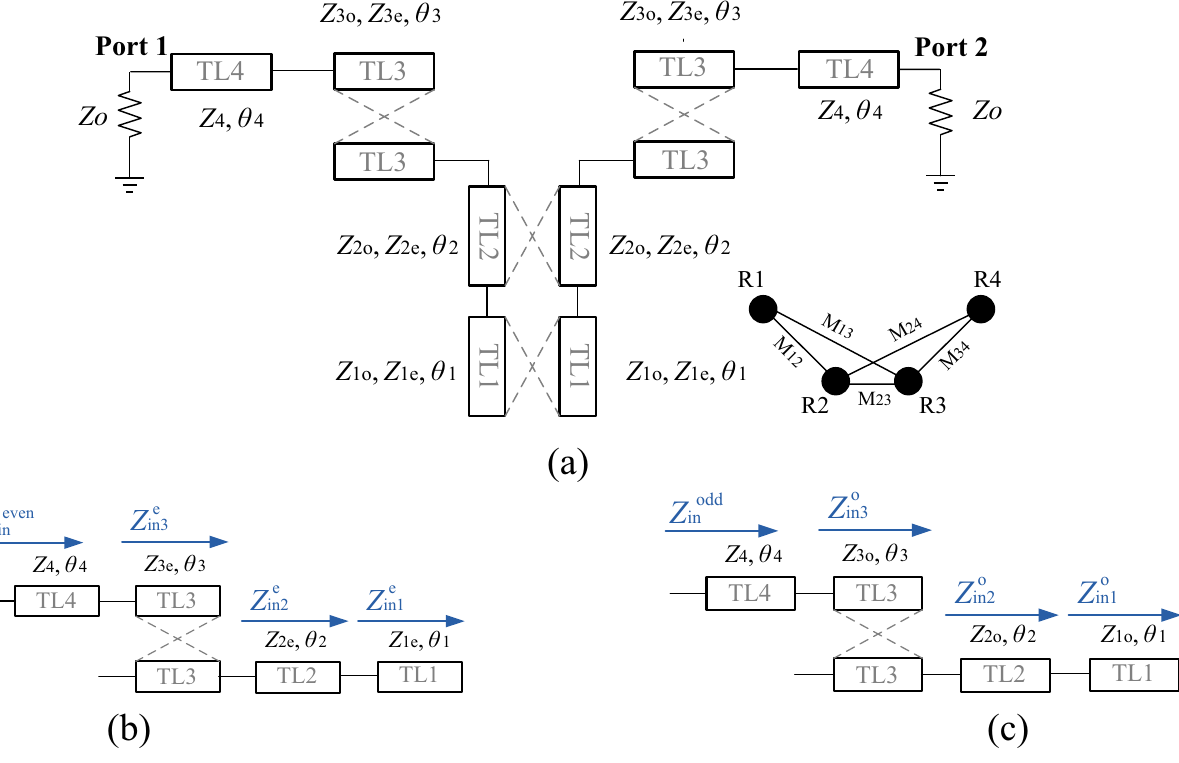
Figure 1. ( a ) Equivalent circuit model of the proposed BPF with coupling graph, ( b ) even and, ( c ) odd